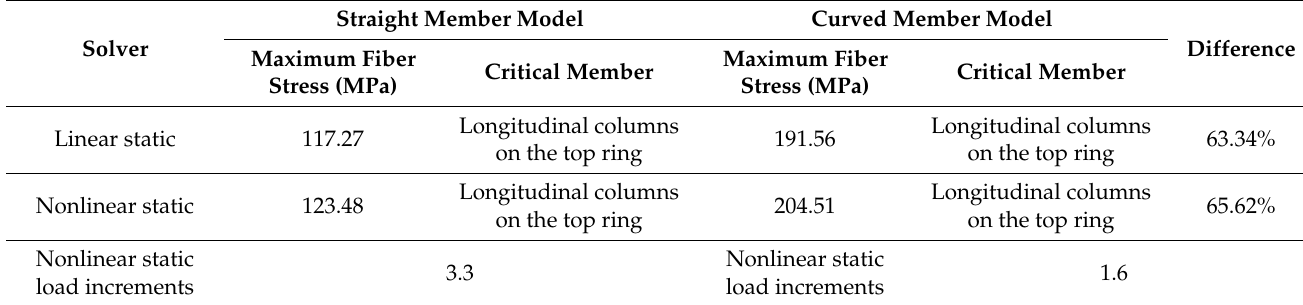
Table 8. Fiber stresses under 1.2G + W.